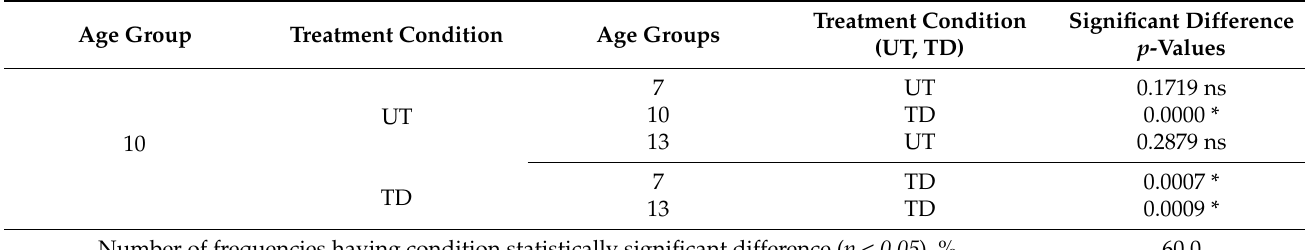
Table 5. ANOVA on the effect of age groups and treatment conditions with 10-year-old Acacia hybrid untreated and treated for tensile samples at air-dry